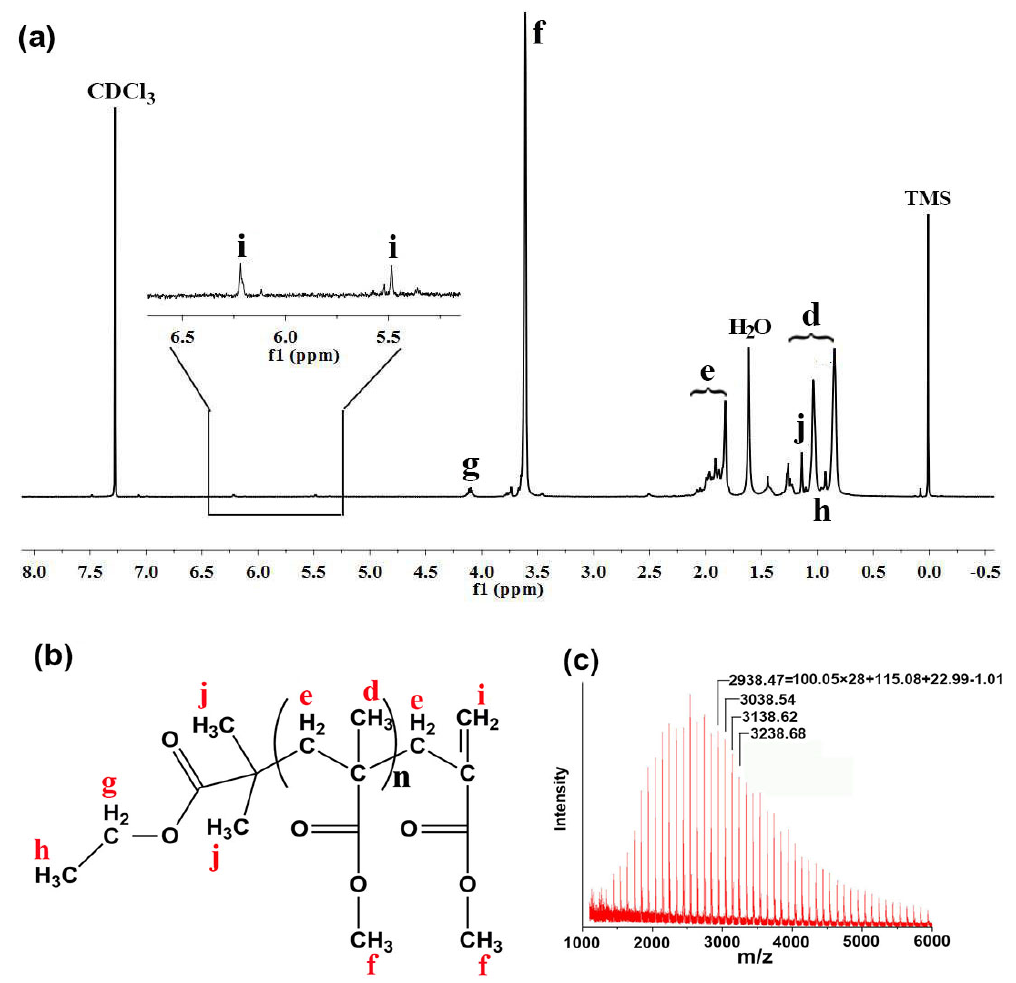
Figure 3. 1 H NMR spectrum ( a ), structural formula ( b ), and MALDI-TOF result ( c ) of poly(methyl